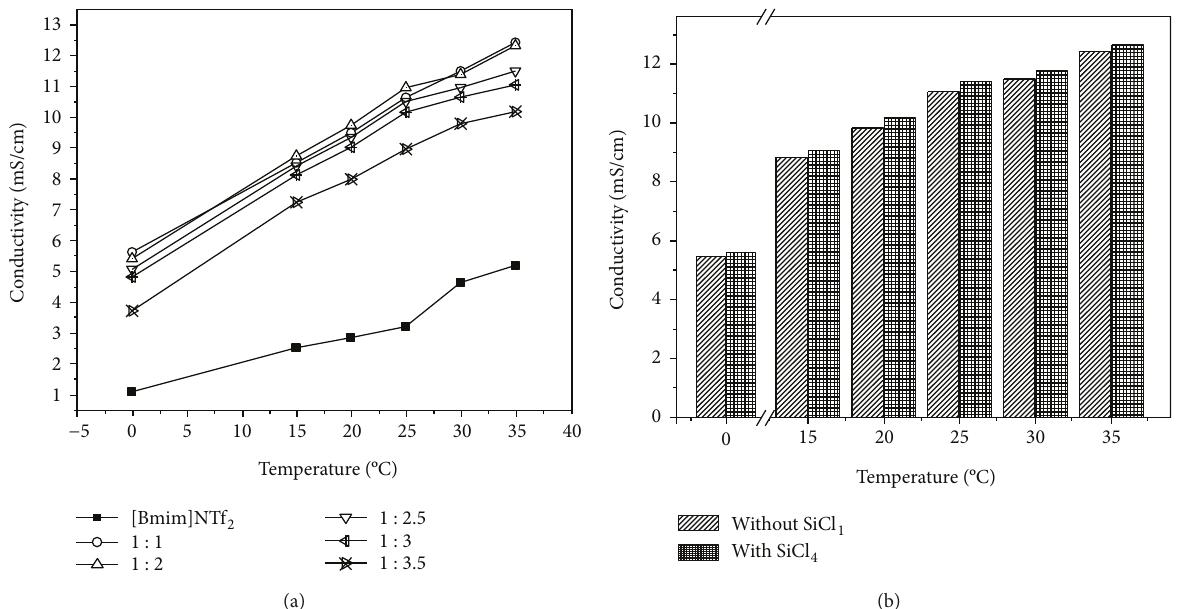
Figure 2: (a) Conductivity of [Bmim]NTf at a ratio of 1 :2 and following the dissolution of SiCl